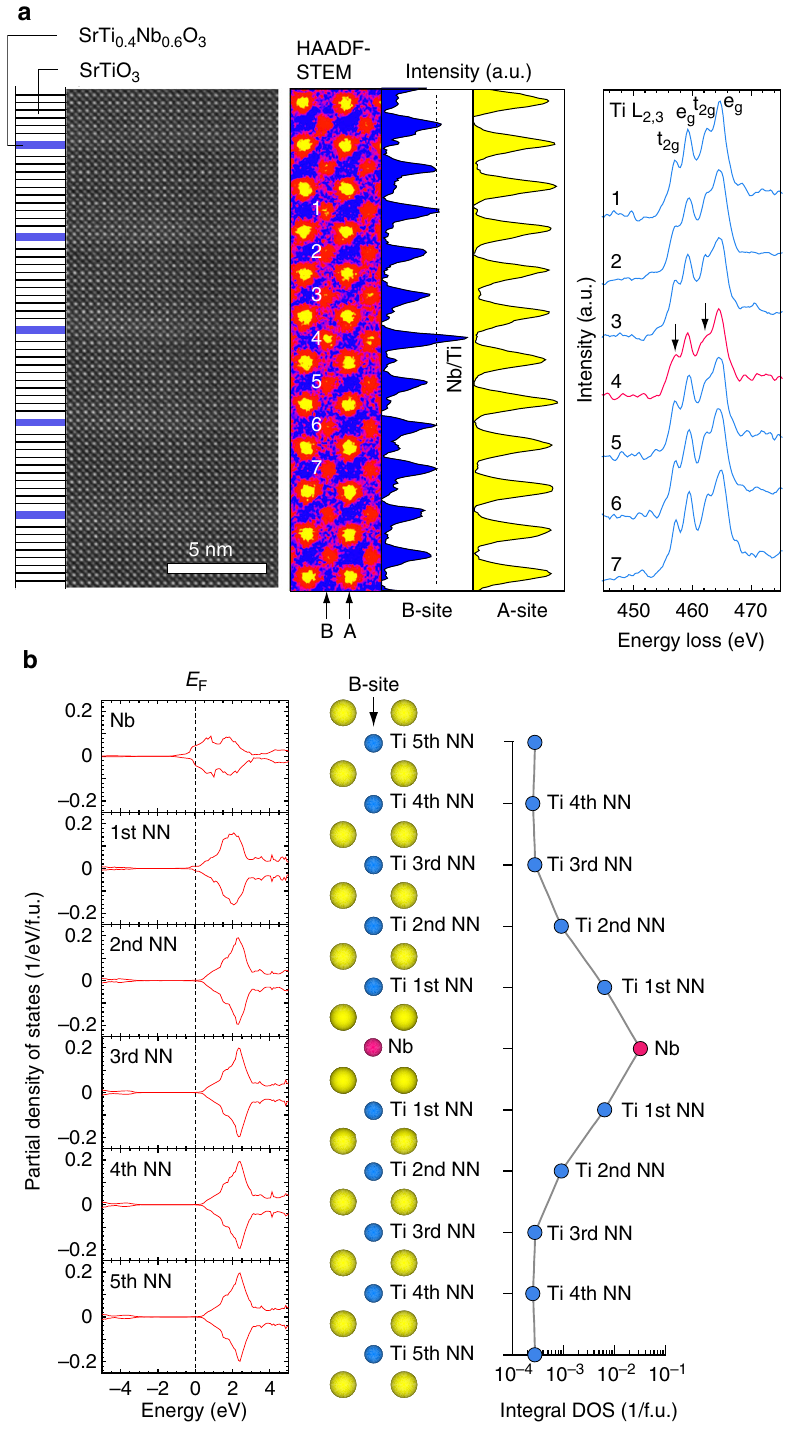
Fig. 3 Experimental and theoretical analyses of the 2DES. a Cross-sectional HAADF-STEM image of the [1 uc SrTi 0.4 Nb 0.6 O 3 |11 uc SrTiO 3 ] 10 superlattice. Layer stacking sequence is also shown. Rather bright bands are seen near each SrTi 0.4 Nb 0.6 O 3 layer. In the magni fi ed image, the #4 atom in the B-site column is brighter than the nearby atoms, whereas no obvious difference is observed in the A-site column. EELS spectrum of #4 is broader than that of nearby atoms, indicating the coexistence of Ti 4 + /Ti 3 + in the SrTi 0.4 Nb 0.6 O 3 layers. b The calculated partial DOS of Nb 4 d or Ti 3 d in the [1 uc SrNbO 3 |10 uc SrTiO 3 ] superlattice. The Fermi energy ( E F ) is located on the higher-energy side of the conduction band minimum for the fi rst and second nearest neighbor (Ti fi rst NN and Ti second NN). SrTiO 3 layers together with 1 uc SrNbO 3 layer (Nb) suggest that the electron carriers can seep from the SrTi 1 − x Nb x O 3 layers into the SrTiO 3